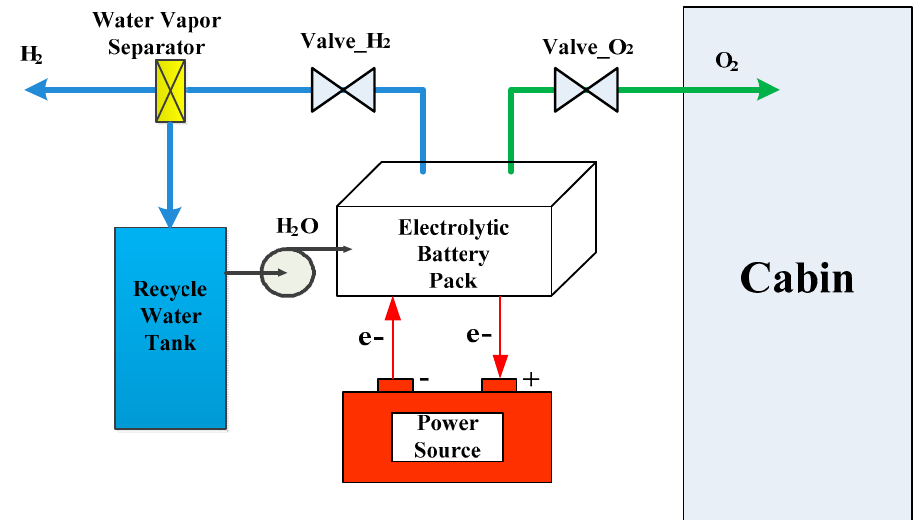
Figure 4. The simplified workflow sketch of EOGS.